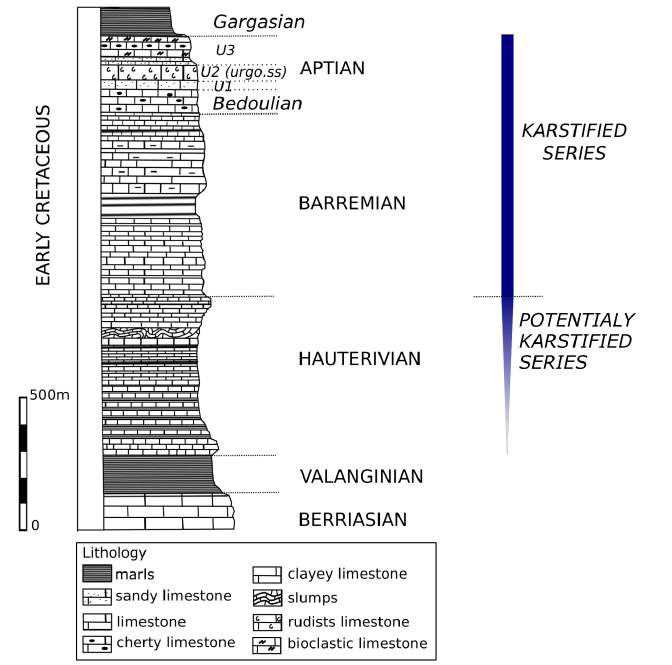
Figure 2. Geological log of Fontaine de Vaucluse aquifer, modified after Puig